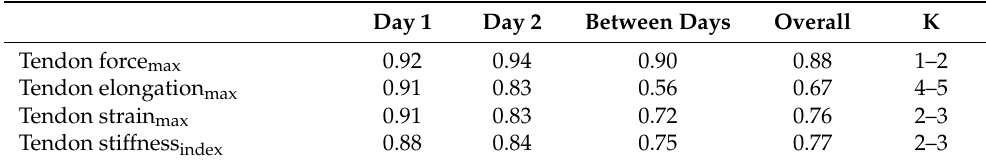
Table 4. Intraclass correlation coefficient values within-day, between-day, and overall, as well as the least number of trials (K) required within-day (measurement session) to provide reliable values for the analyzed parameters describing the mechanical properties of the Achilles